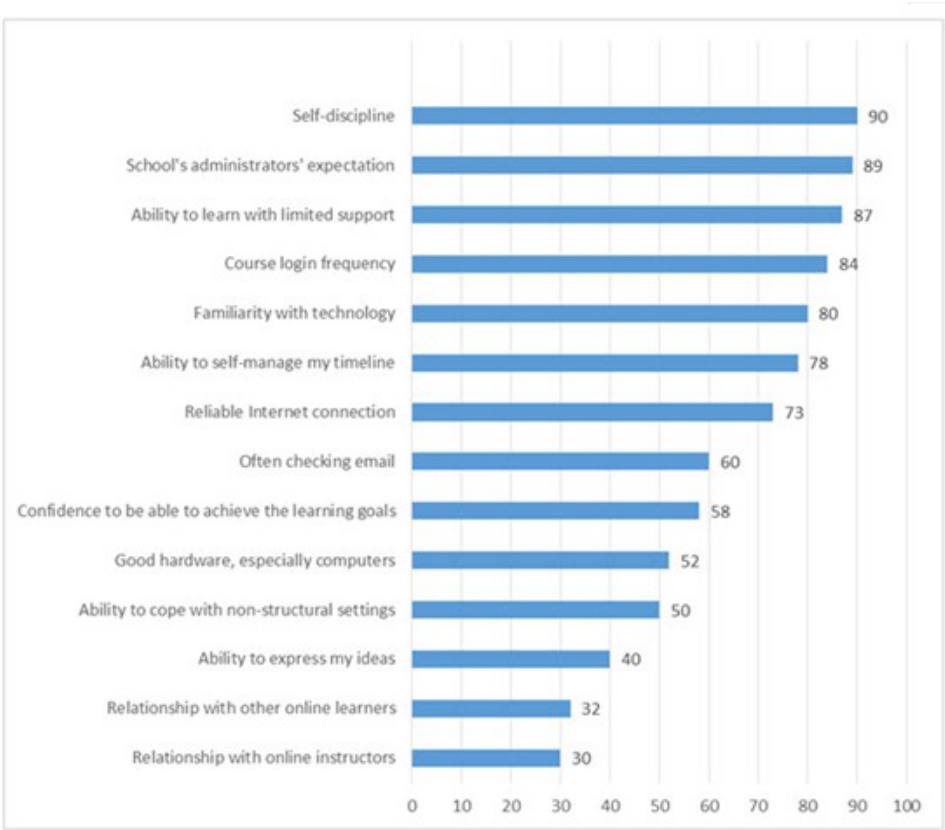
Figure 3 . Factors leading to successful completion of the online professional training course.